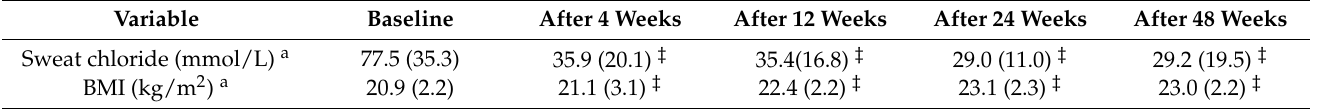
Table 3. Absolute changes in sweat chloride and BMI over the 48-week treatment period. Variable Baseline After 4 Weeks After 12 Weeks After 24